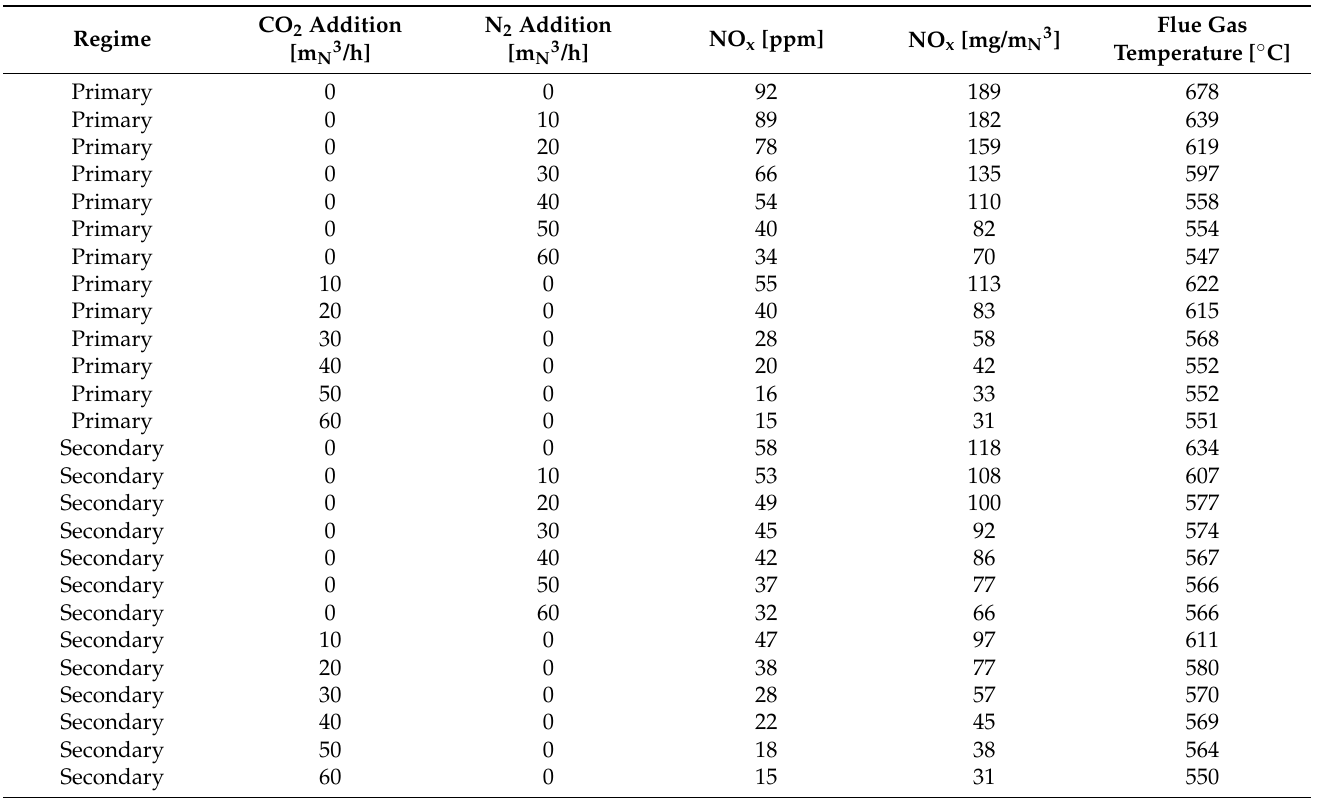
Table 5. Experimental matrix—TEST A—Burner